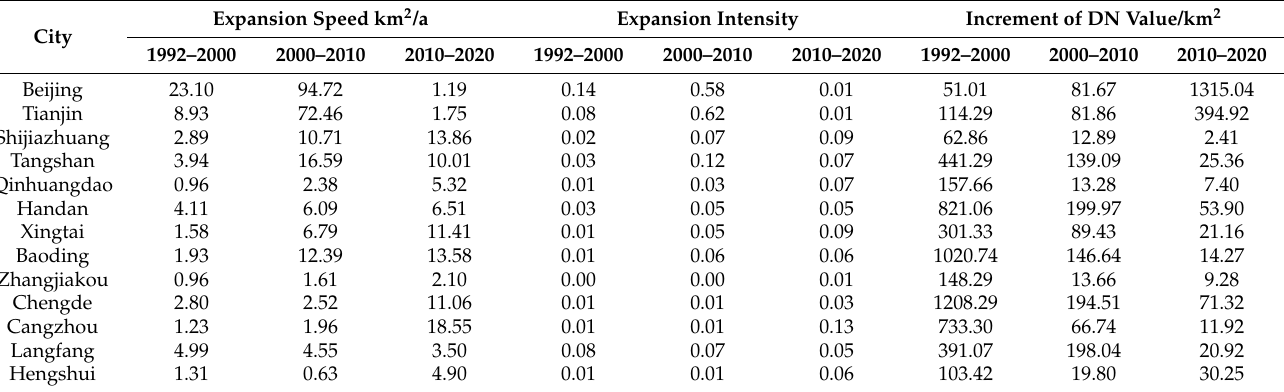
Table 2. Differences in Urban Expansion in the Beijing–Tianjin–Hebei Urban Agglomeration